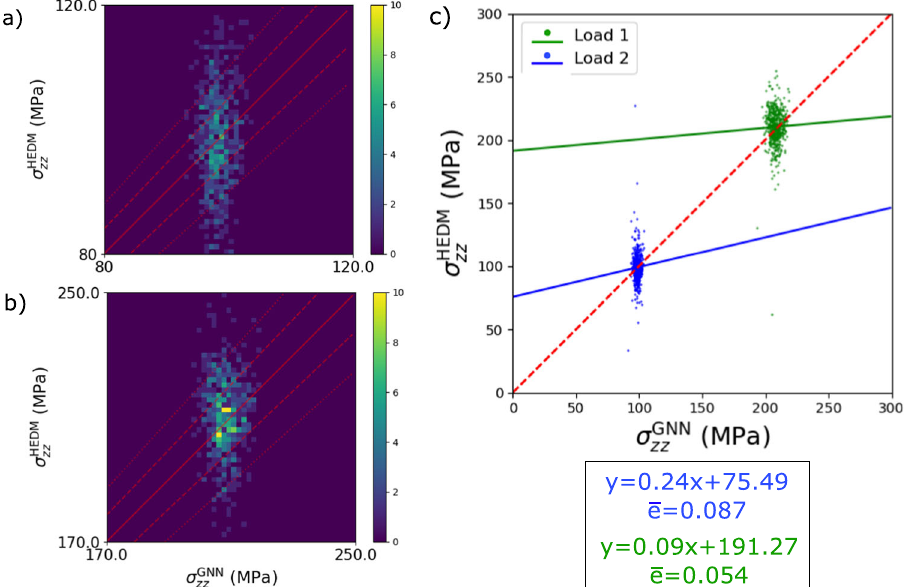
Fig. 6 Comparisons of stress predictions along the loading direction ( σ zz ) from GNN surrogate models using lattice orientation as nodal features with those measured using ff-HEDM during in situ elastic loading for Ti-7Al. Histograms of comparisons at a Load 1 (applied strain of 0.0009) and b Load 2 (applied strain of 0.0018). c Scatter plot comparing GNN predictions and ff-HEDM results from the two load steps along with regression lines fi t to the